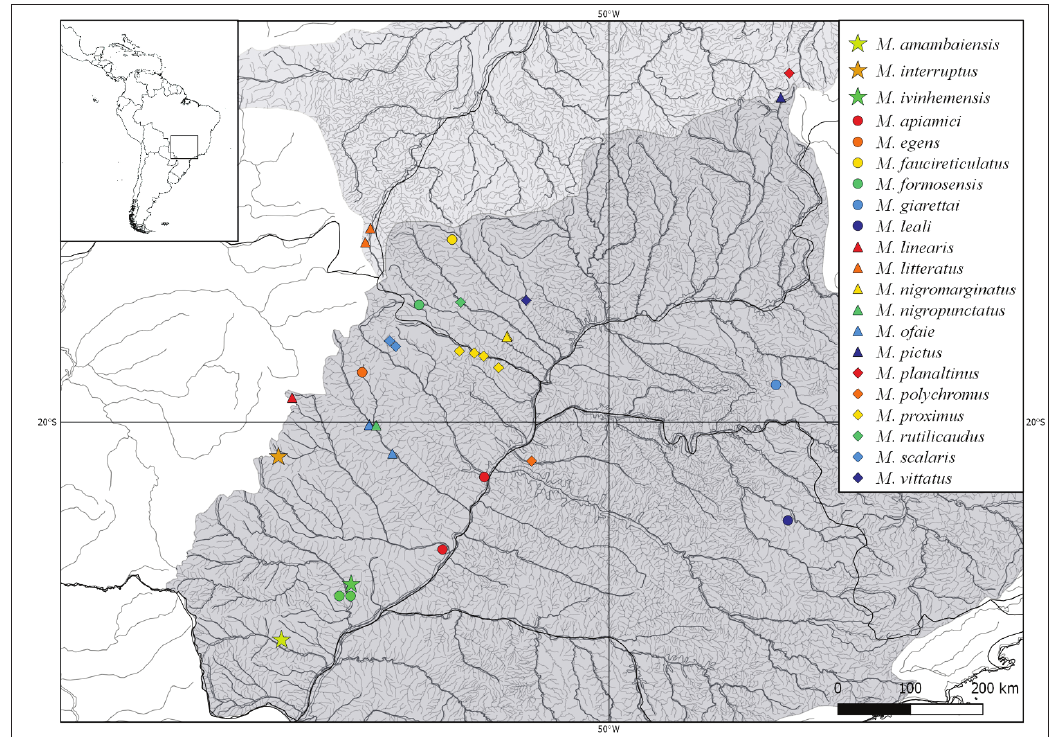
Figure 3. Distribution of species of the Melanorivulus pictus group in the Rio Paraná (grey) and Rio Araguaia and Tocantins (light grey) basins. Stars indicate the type localities of the new